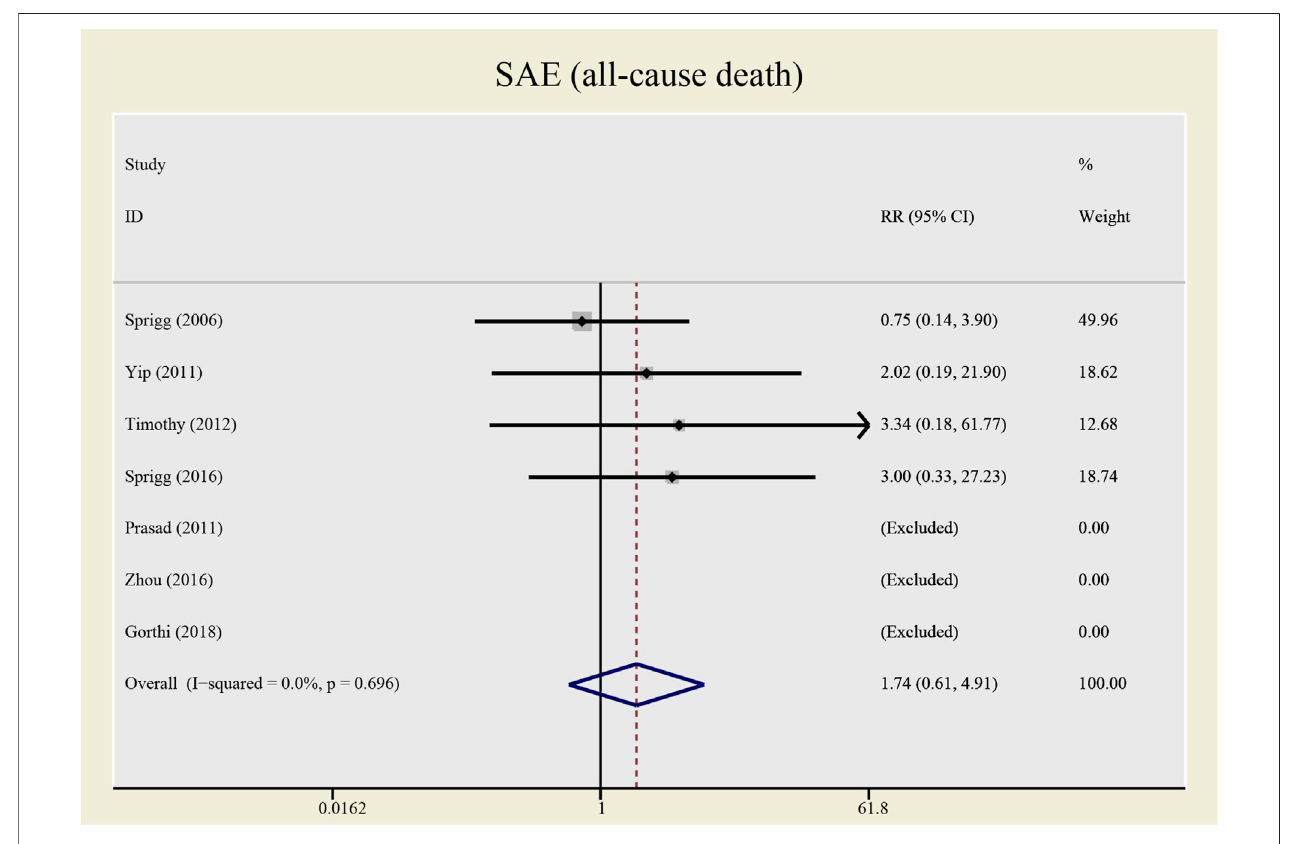
FIGURE 5 | Forrest plot for SAE (all-cause